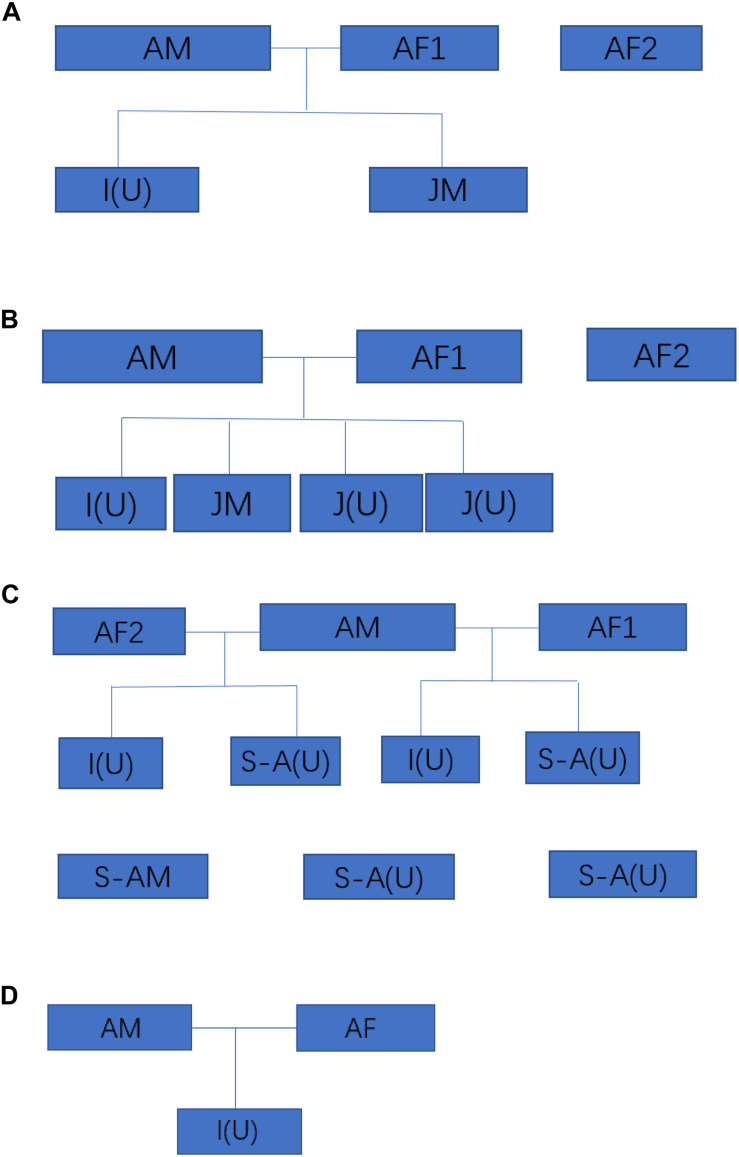
The size and composition four wild Hainan gibbon groups. AM represents an adult male, AF represents an adult female, S-A represents a subadult, JM represents a juvenile, I represents an infant, and (U) represents an adult, subadult, juvenile, or infant of unknown sex. Infants are 0–24 months of age, juveniles are >2–7 years of age, subadults are >7–9 years of age, and adults are >9 years of age.